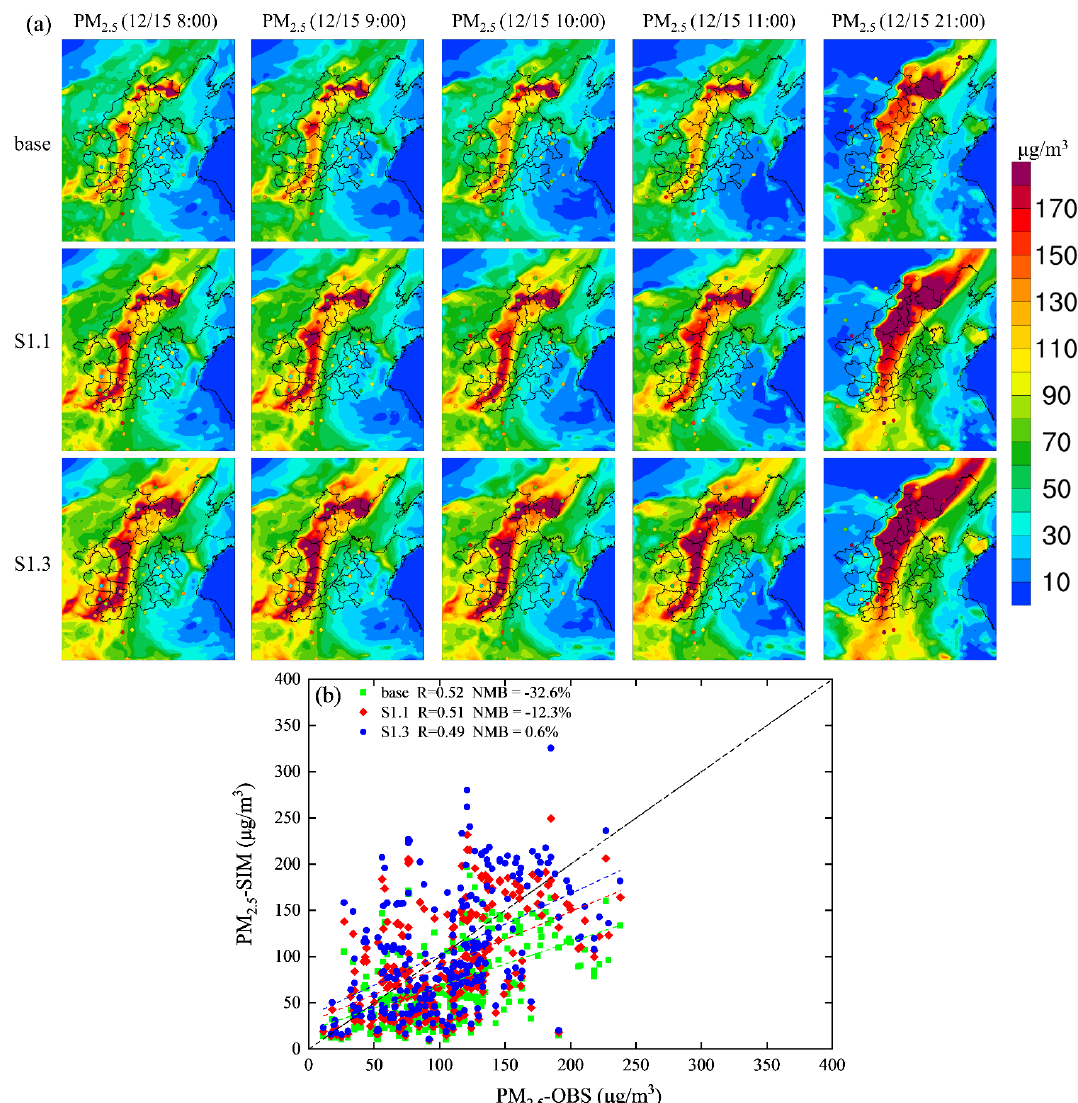
Figure 10. (a) Spatial distributions of hourly PM 2 . 5 concentrations at some peak hours over the BTH2 + 26 and some other surrounding cities under the base, S1.1, and S1.3 scenarios. The colored dots denote the observed values for each city. (b) Scatterplots and linear regressions of observed (OBS) and simulated (SIM) hourly PM 2 . 5 concentrations for all cities under the base, S1.1, and S1.3